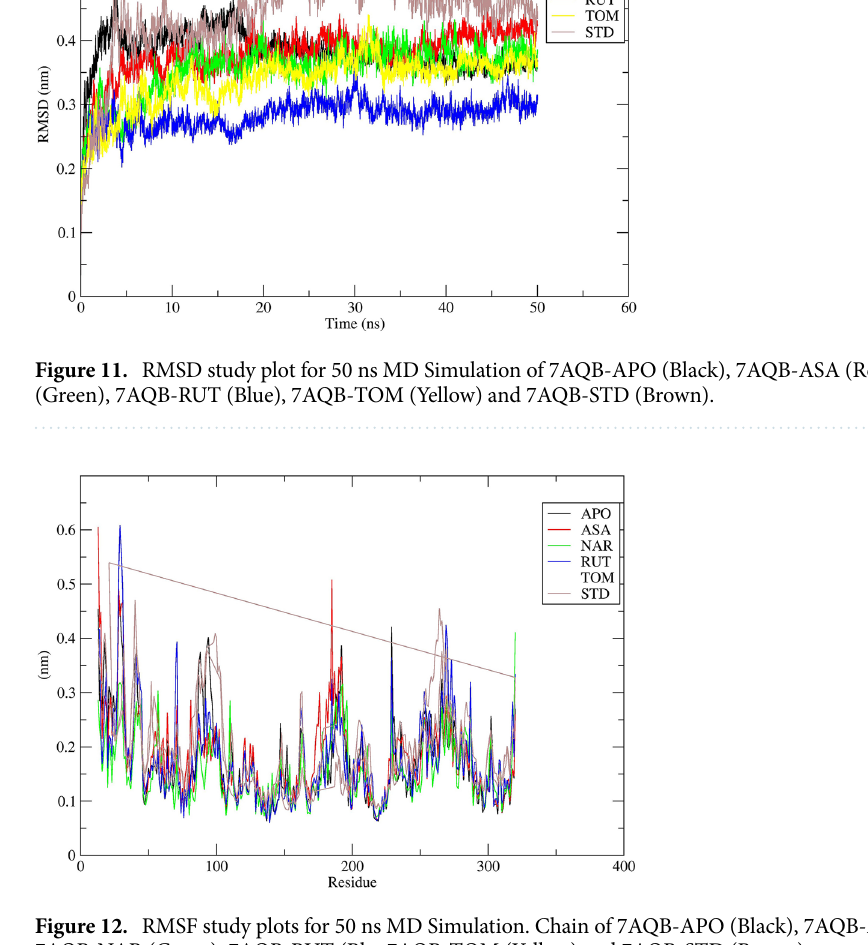
Figure 12. RMSF study plots for 50 ns MD Simulation. Chain of 7AQB-APO (Black), 7AQB-ASA (Red), 7AQB-NAR (Green), 7AQB-RUT (Blue7AQB-TOM (Yellow) and 7AQB-STD